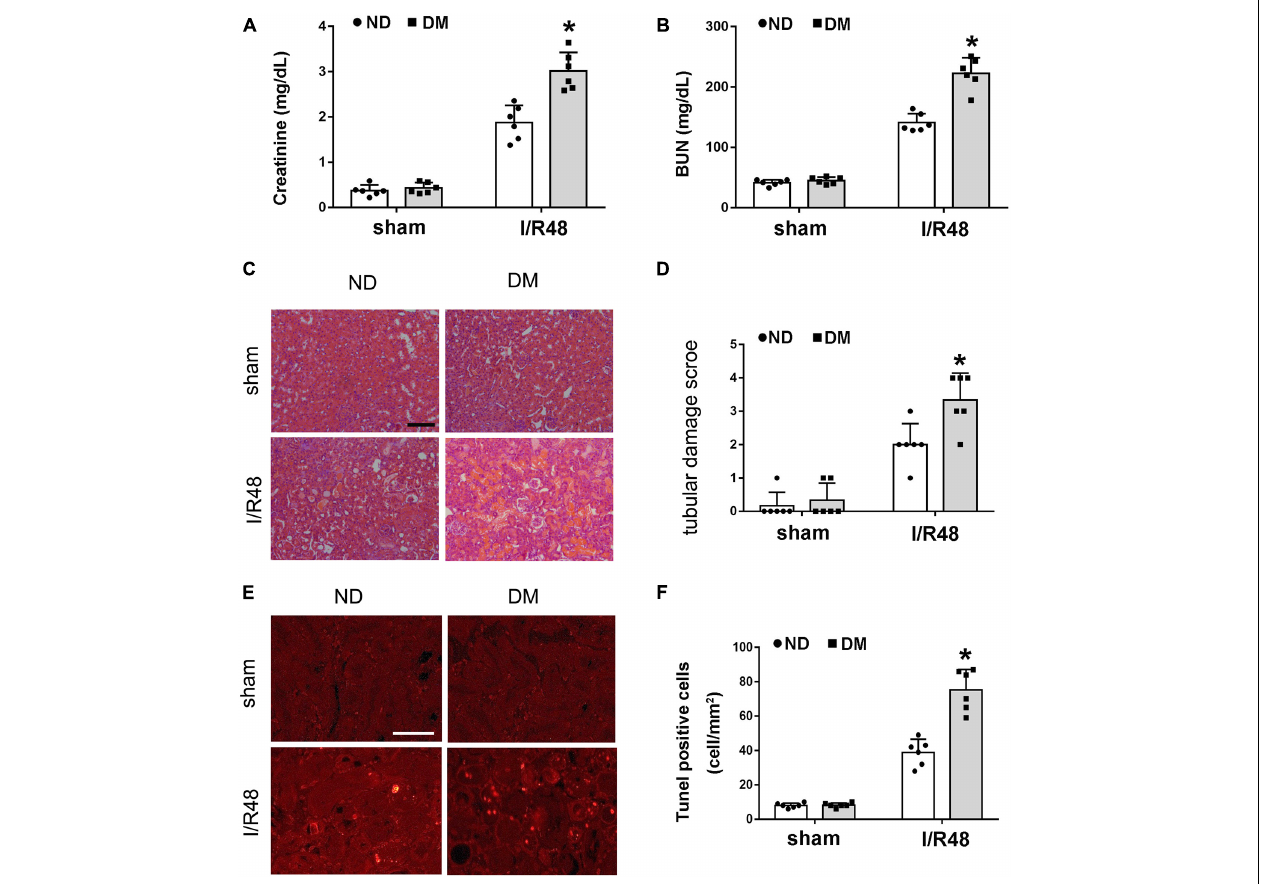
FIGURE 2 | Streptozotocin (STZ)-induced diabetic mice are more susceptible to ischemic acute kidney injury (AKI). Male C57BL/6J mice were injected with STZ or vehicle solution to induce diabetic mice (DM) or non-diabetic mice (ND). The mice were then subjected to sham operation or 30 min of bilateral renal ischemia followed by 48 h of reperfusion (I/R48). (A,B) Serum creatinine and blood urea nitrogen (BUN). (C) Hematoxylin and eosin (HE) staining for renal tissues. Scale bar, 100 µ m. (D) Semi-quantification for renal tissue damage. (E) TUNEL assay to reveal apoptosis of renal tissues. Scale bar, 50 µ m. (F) Statistical analysis for TUNEL-positive cells. All the data are shown as the mean ± SD ( n = 6). * p < 0.05 vs. the relevant ND group.